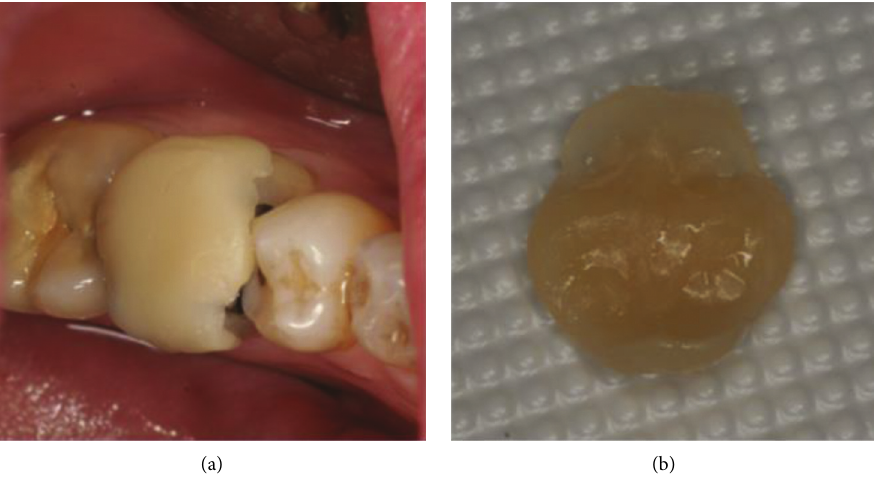
Figure 5: A DCS restoration utilized as a diagnostic aid: (a) upper view of the restoration; (b) lower view of the restoration